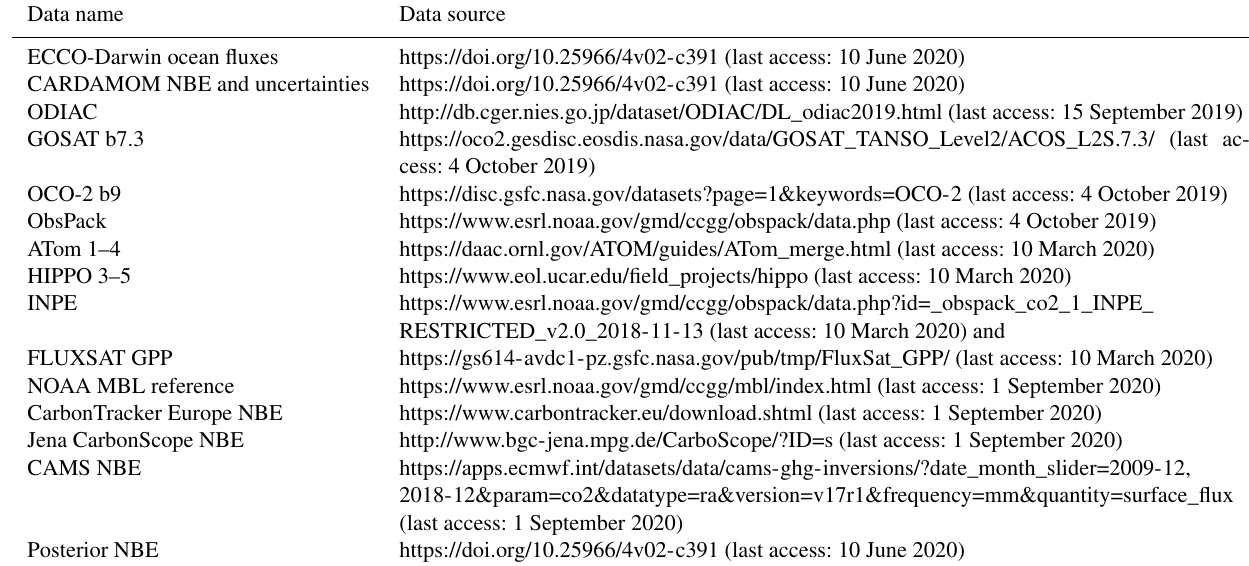
Table 7. Lists of data sources used in producing and evaluating the posterior NBE